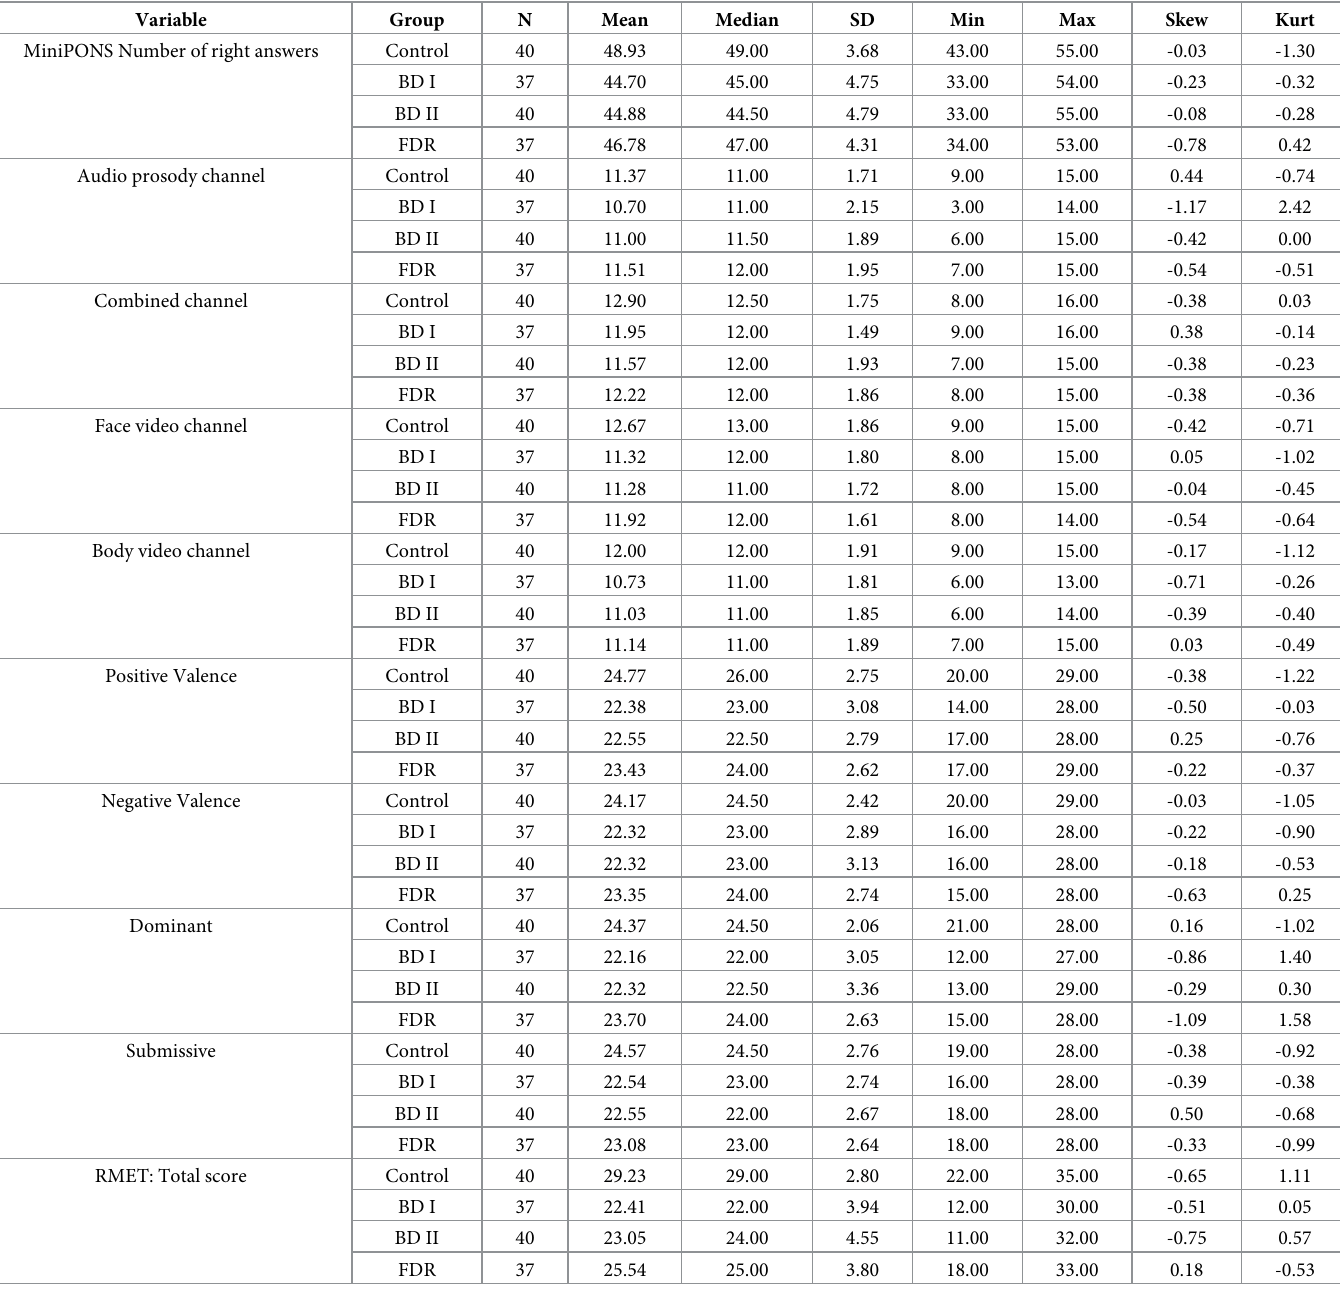
Table 2. Descriptive